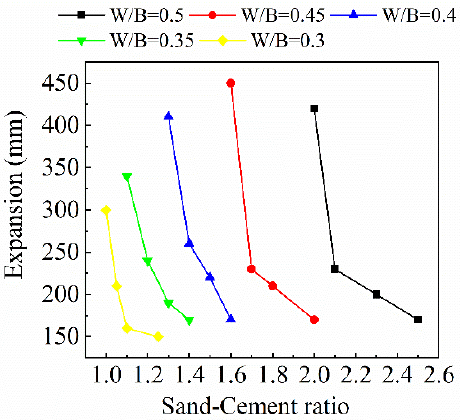
Figure 3. Variation of expansion with sand-cement ratio under various w / b ratio.